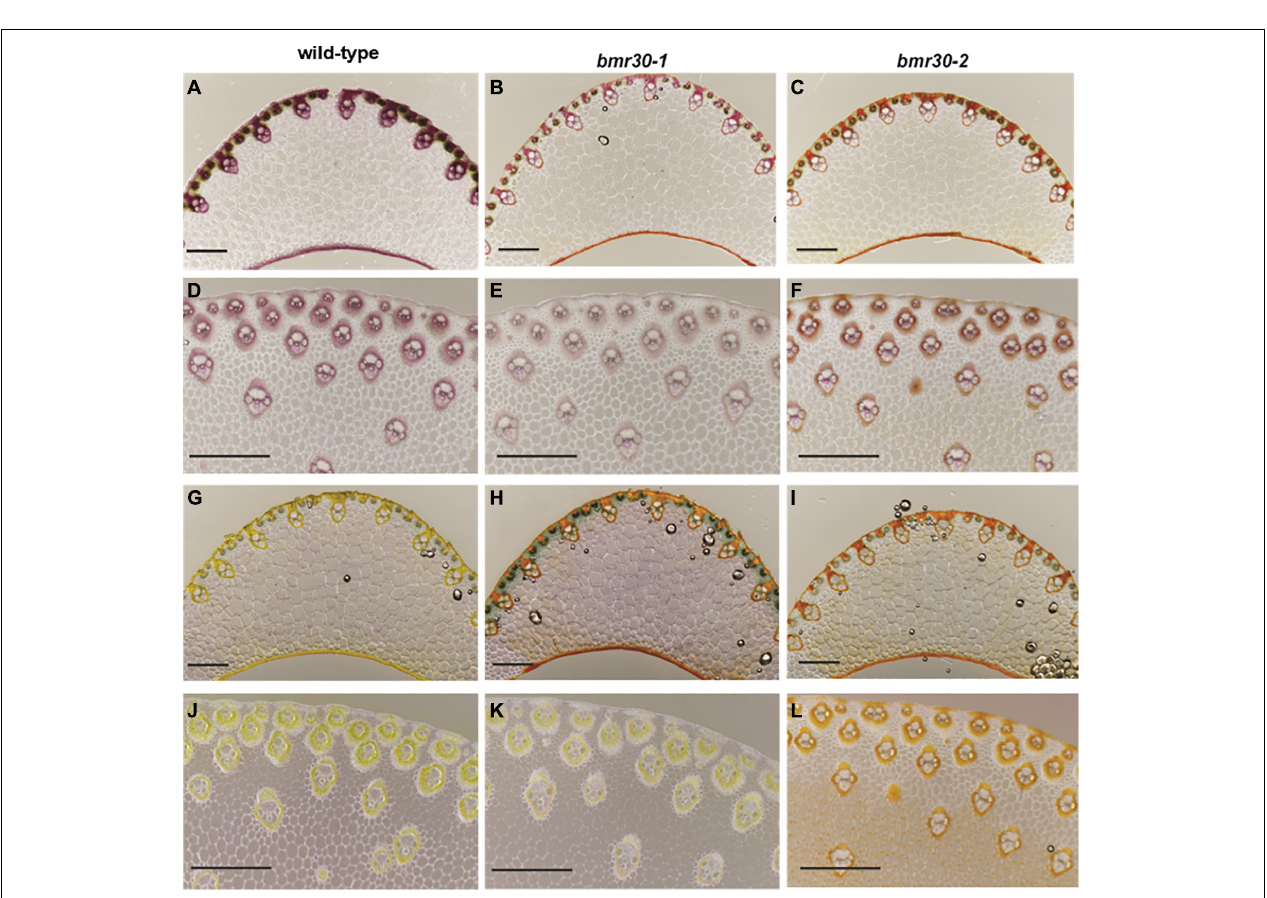
FIGURE 3 | Chalcone isomerase activity from (A) purified wild-type recombinant protein and a version containing the bmr30-1 mutation, and (B) plant stalk extracts of wild type, bmr30-1 , and bmr30-2 . CHI activity levels were assayed using naringenin chalcone substrate. The enzyme velocity was normalized to the amount of protein (mg) added to the reaction. Error bars represent standard error. Samples with different letters are statistically different at α ≤ 0.05 using Tukey’s HSD test.